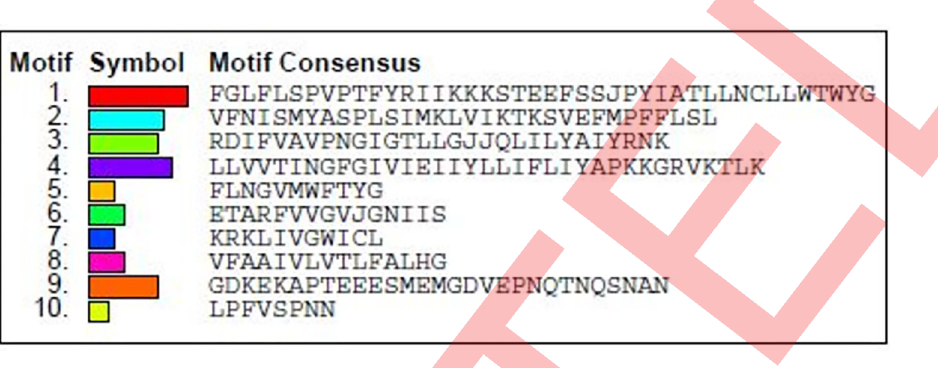
Fig 7. Representation of protein motif and its conserved amino acid sequences present across 155 SWEET proteins sequence. The height of a letter indicates its relative frequency at the given position (x-axis) in the motif.